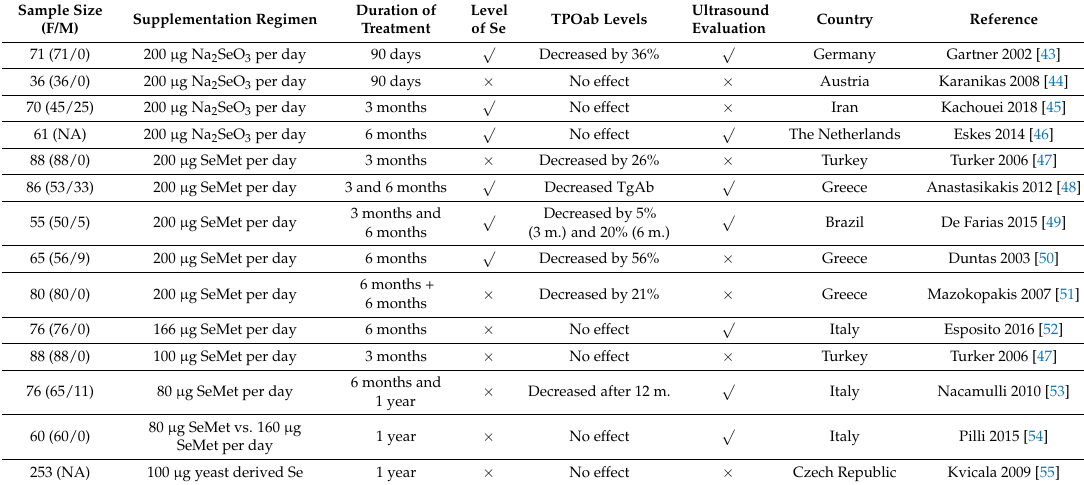
Table 2. Summary of studies of selenium supplementation in patients with Hashimoto’s thyroiditis and corresponding